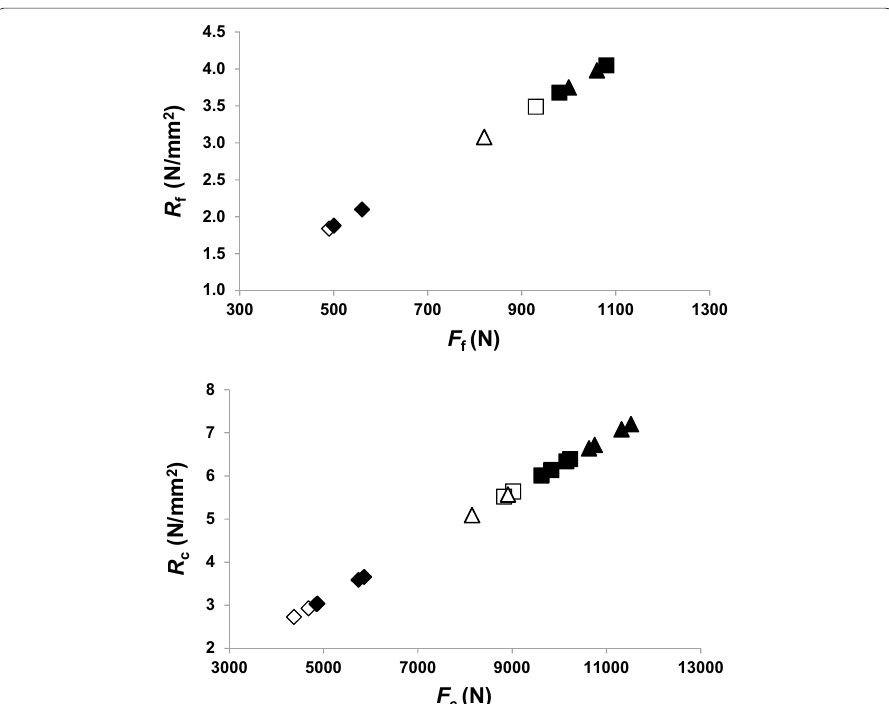
Fig. 1 Diagram reporting the flexural ( R f ) and uniaxial compressive ( R c ) strengths at the fracture point for the starting and doped ( 5 and 10% of graphite powder) bentonitic grouts as a function of the load applied + + to the sample ( F f and F c ). Symbols are as follows: diamonds for the starting grout; squares for the grout of graphite powder; triangles for the grout 10% of graphite powder. Open symbols are for tests at 14 days, + filled symbols for those at 28 days